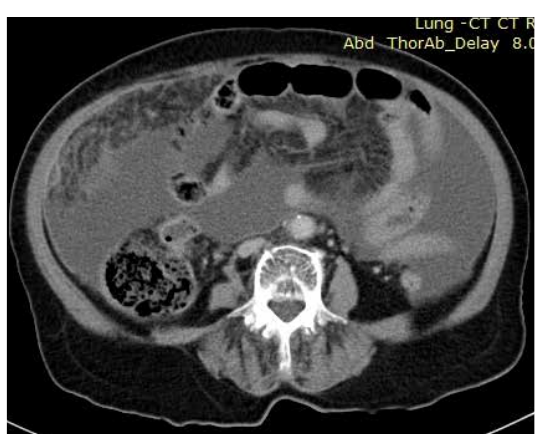
Figure 3 Computerized tomography showed that the omentum in the right upper abdomen was thickened